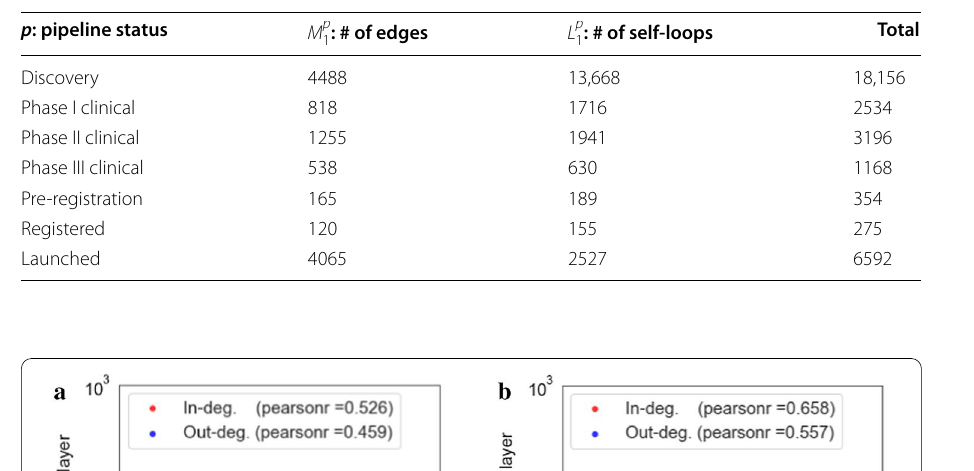
Table 4 The number of edges and self-loops for each pipeline status in the drug pipeline layer